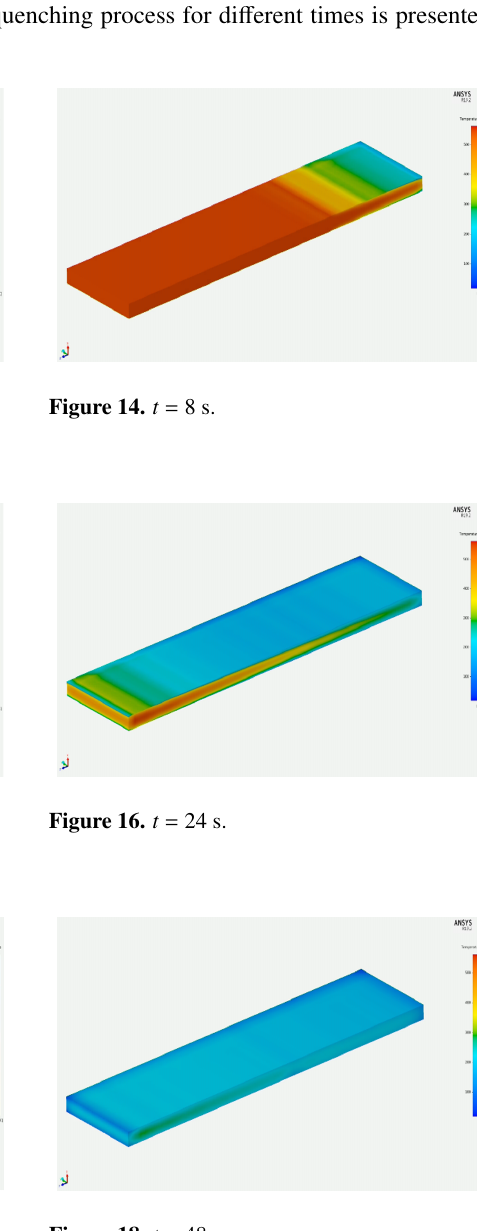
Figure 17. t = 32 s. Figure 18. t = 48